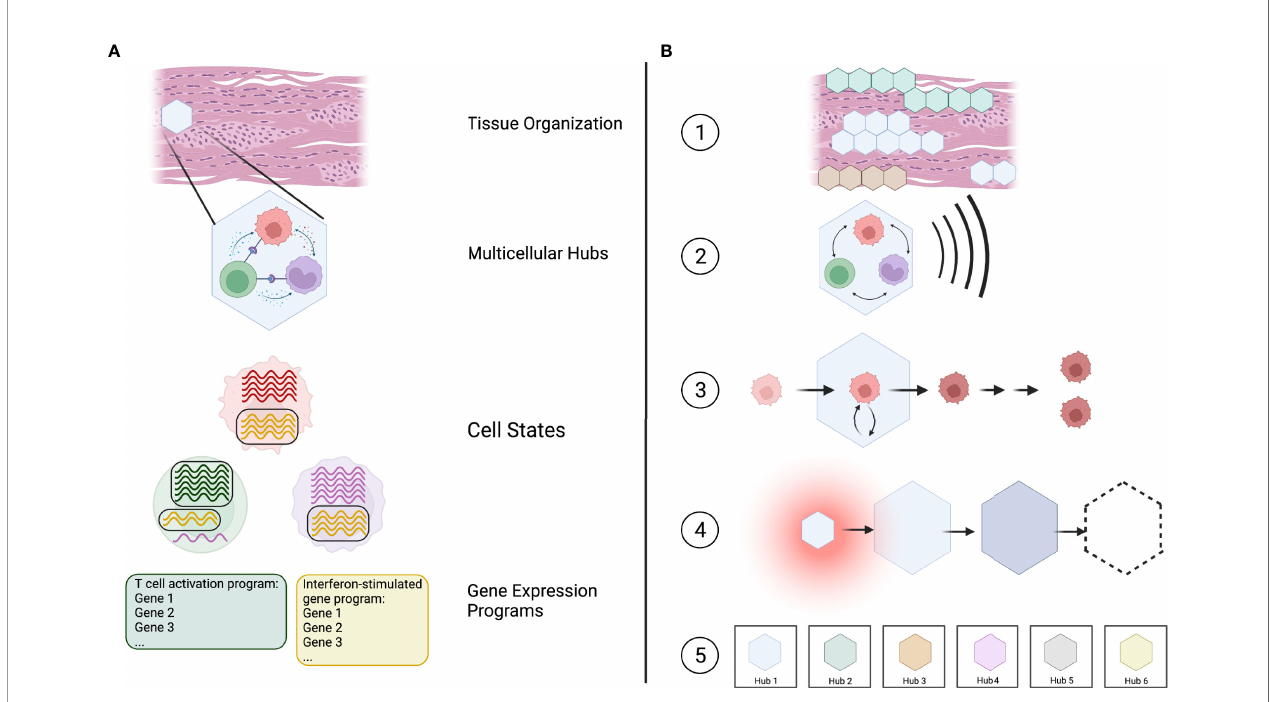
FIGURE 1 | Multicellular hubs as coordinated modules in a hierarchical model of tissue organization and function. (A) Tissues can be viewed as a combination of multicellular hubs. Multicellular hubs are composed of interacting cells that express particular gene expression programs. (B) (1) The combination of type, activity, and location of different spatially organized hubs determines the functional state of the tissue. (2) The function of each hub arises from the concerted action of its cellular components. (3) The cells of the hub are in fl uenced by their interaction with other cells in the hub. (4) Multicellular hubs are not static, but can change over time. (5) The number of different types of hubs is limited, with each type of hub potentially existing in different activation states analogous to cell types and their activation